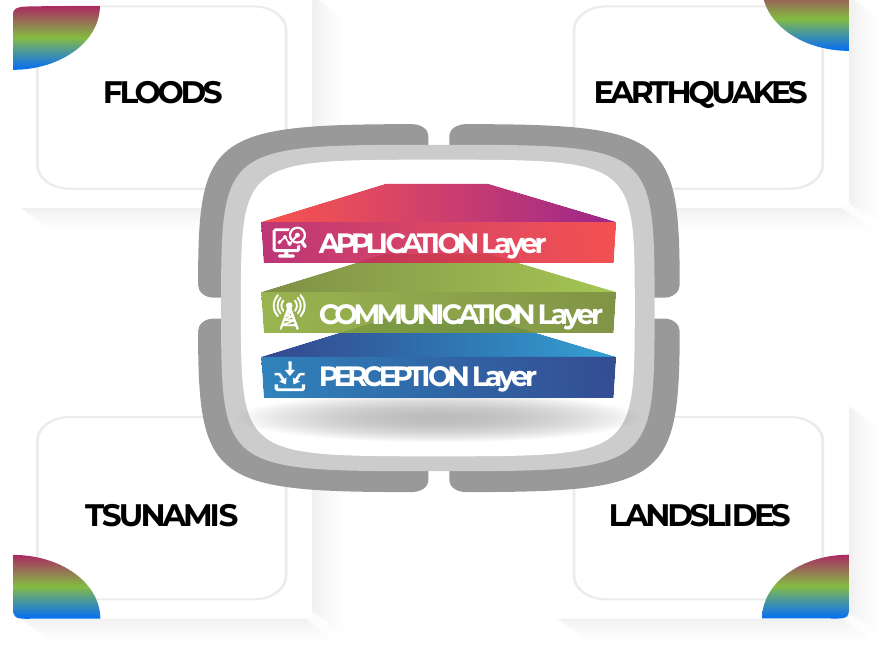
Figure 1. Reference IoT